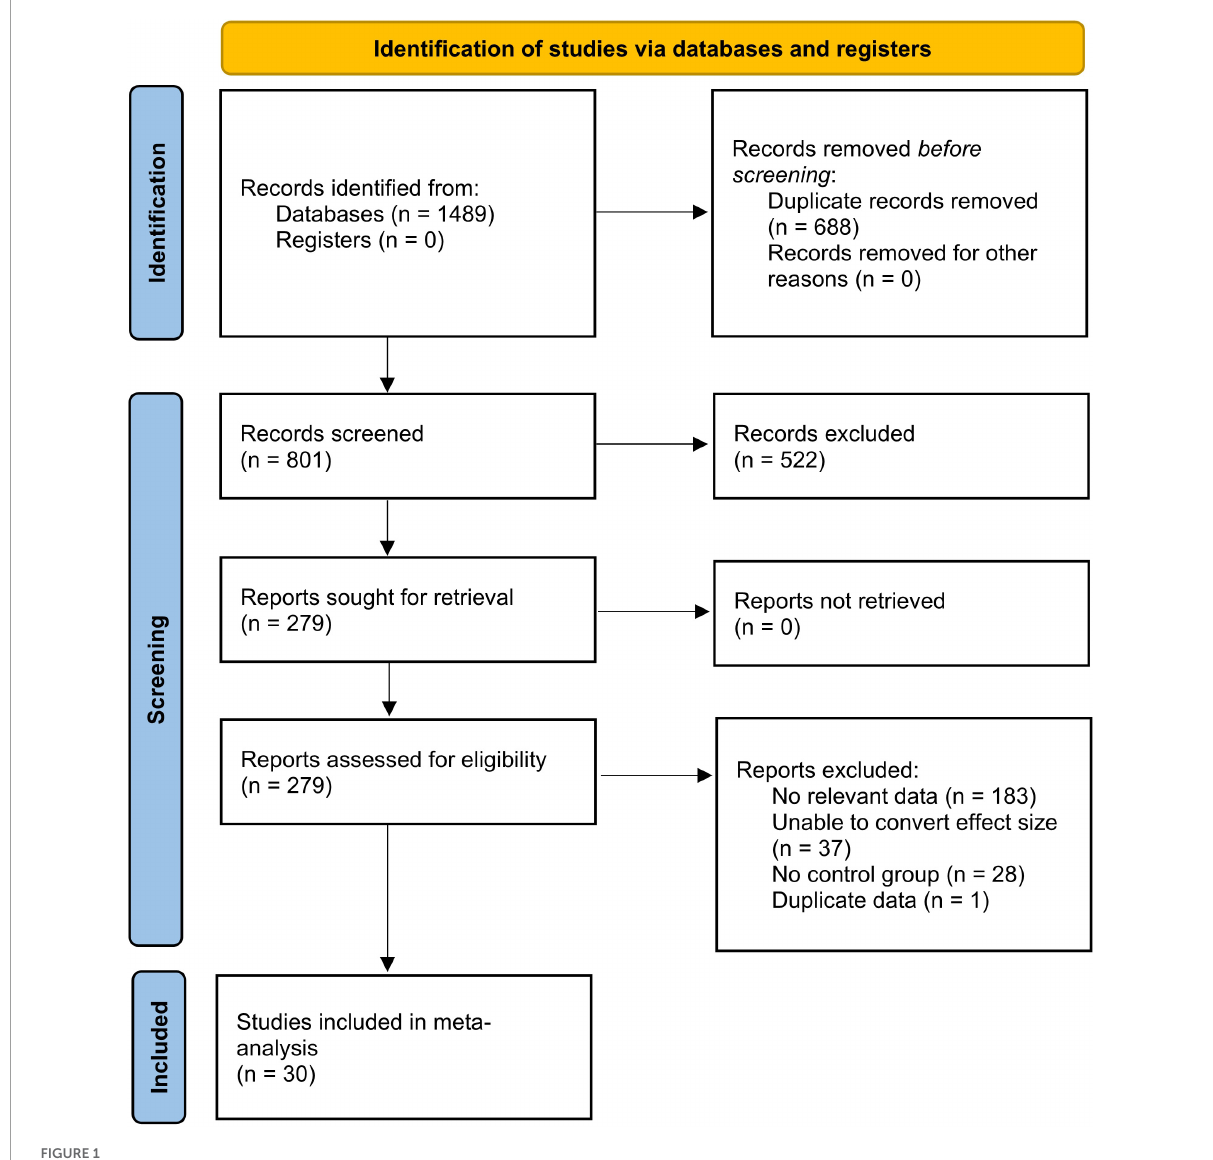
FIGURE1 Flow chart of the identified